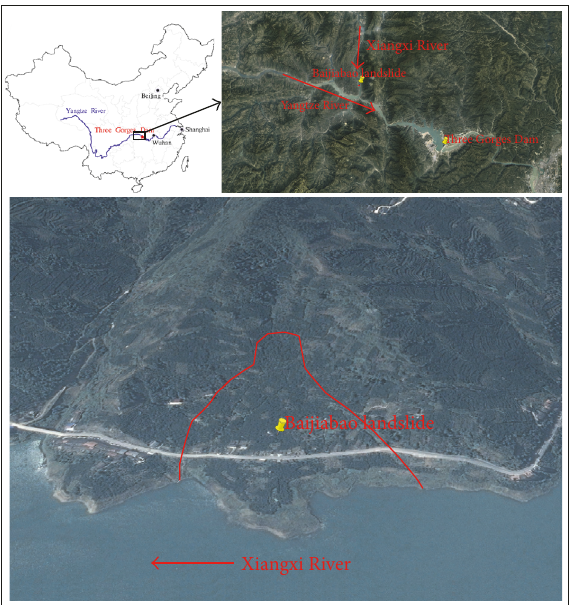
Figure 1: Location of the Baijiabao landslide in Guizhou Town, Zigui County, Hubei Province, central